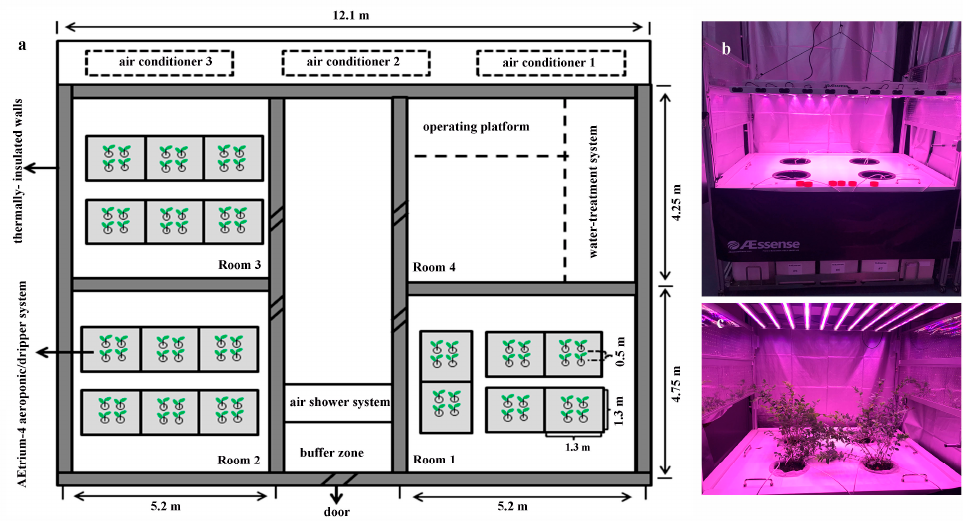
Figure 1. The schematic diagram ( a ), customized AEtrium-4 aeroponic/dripper system ( b ), and blueberry ( c ) cultivated in PFAL.